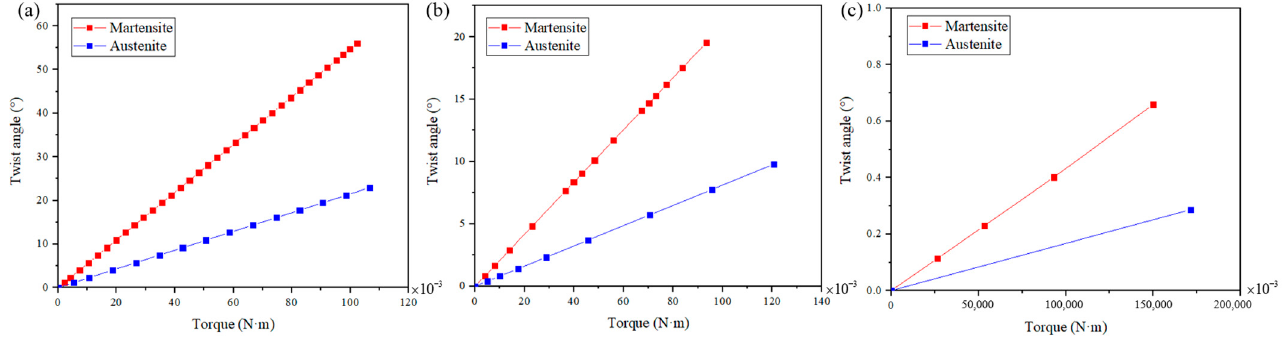
Figure 5. The twist angle-torque responses of ( a ) the spring of the circular cross-section, ( b ) the SMAMS S4 and ( c ) the tube.